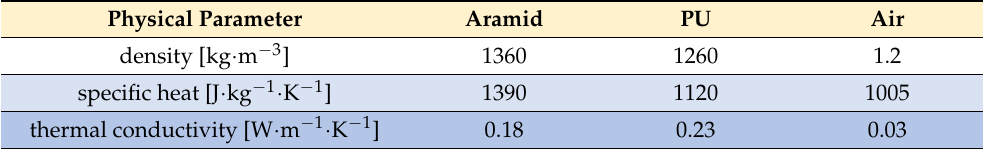
Table 3. Physical features of raw materials applied in heat transfer simulations through tested assembly models.